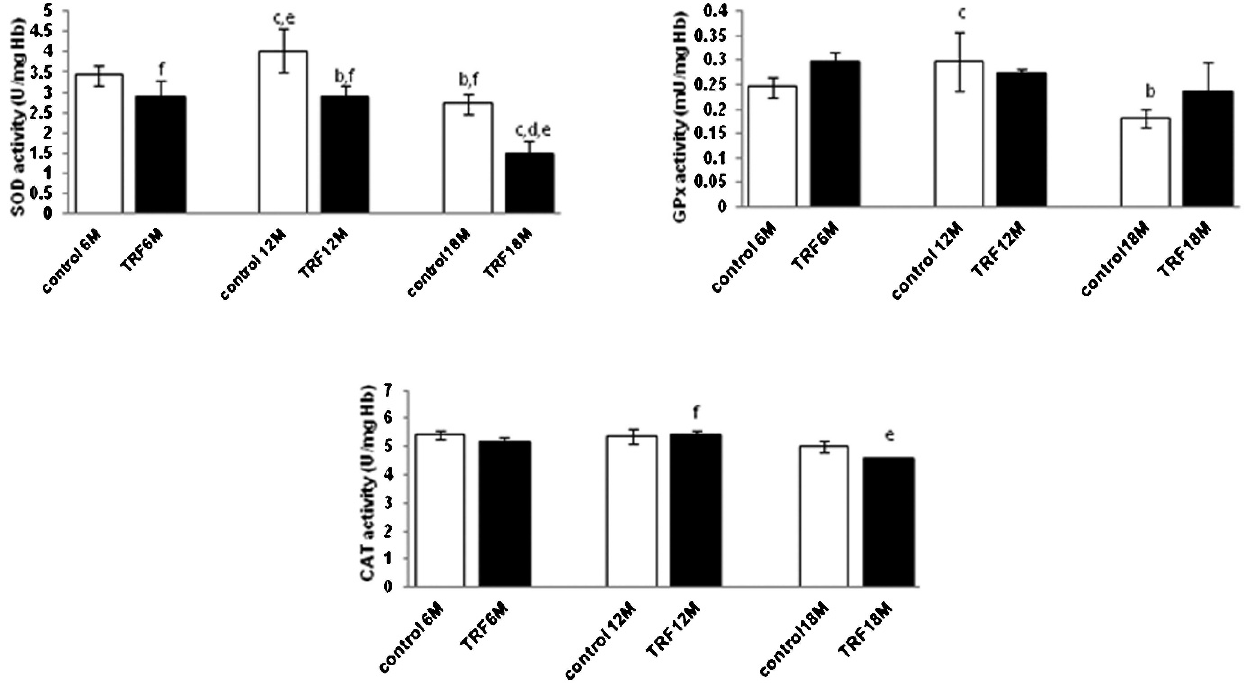
different ( p , 0.05) from TRF at 6 M, 12 M, and 18 M, respectively.